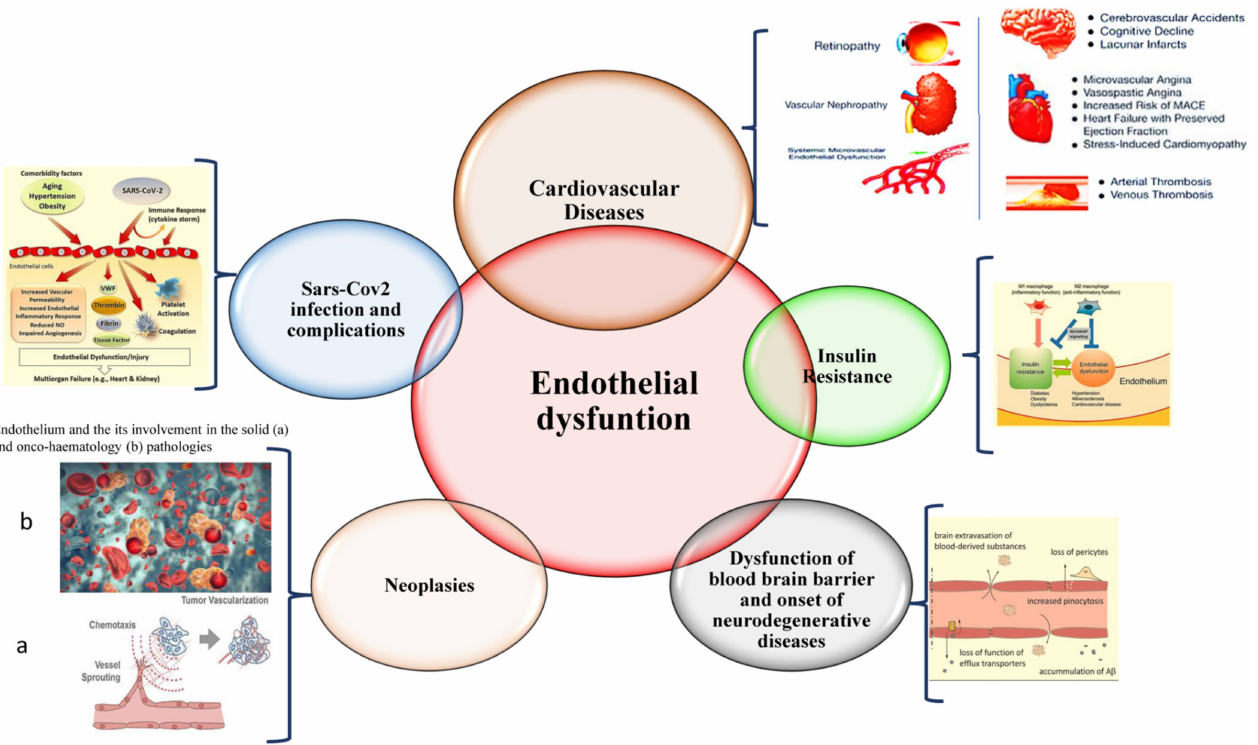
Figure 2. Endothelium dysfunction and its relationship with human diseases.